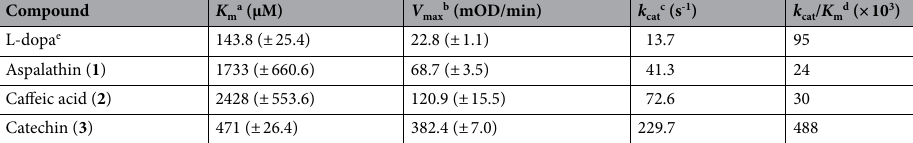
Compound K ma (µM) V maxb